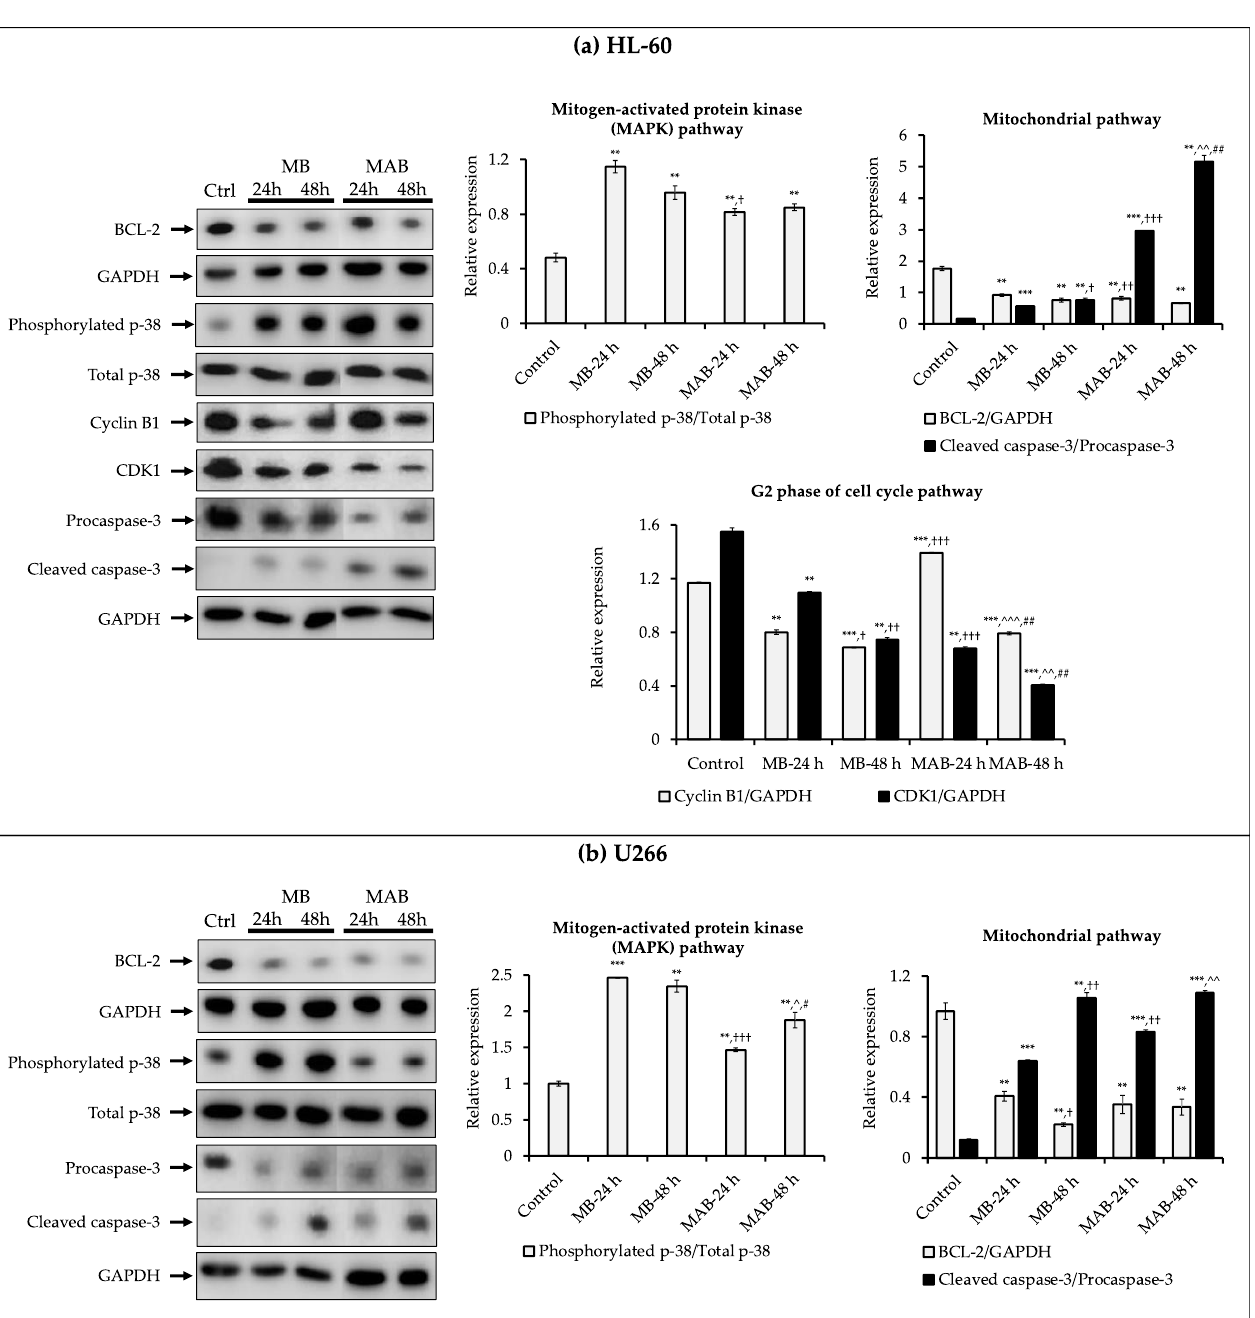
Figure 4. Effects of momilactone B (MB) and the mixture of momilactones A and B (MAB) (1:1, w/w ) on the expressions of proteins related to apoptosis induction and cell cycle arrest of ( a ) acute promyelocytic leukemia (APL) HL-60 and ( b ) multiple myeloma (MM) U266 cell lines after 24 and 48 h. Statistical significance was determined by the t -test. ** p < 0.01 versus control; *** p < 0.001 versus control; † p < 0.05 versus MB-24 h; †† p < 0.01 versus MB-24 h; ††† p < 0.01 versus MB-24 h; ^ p < 0.05 versus MAB-24 h; ^^ p < 0.01 versus MAB-24 h; ^^^ p < 0.001 versus MAB-24 h; # p < 0.05 versus MB-48 h; ## p < 0.01 versus MB-48 h. The uncropped blots are shown in Supplementary Figure S2.